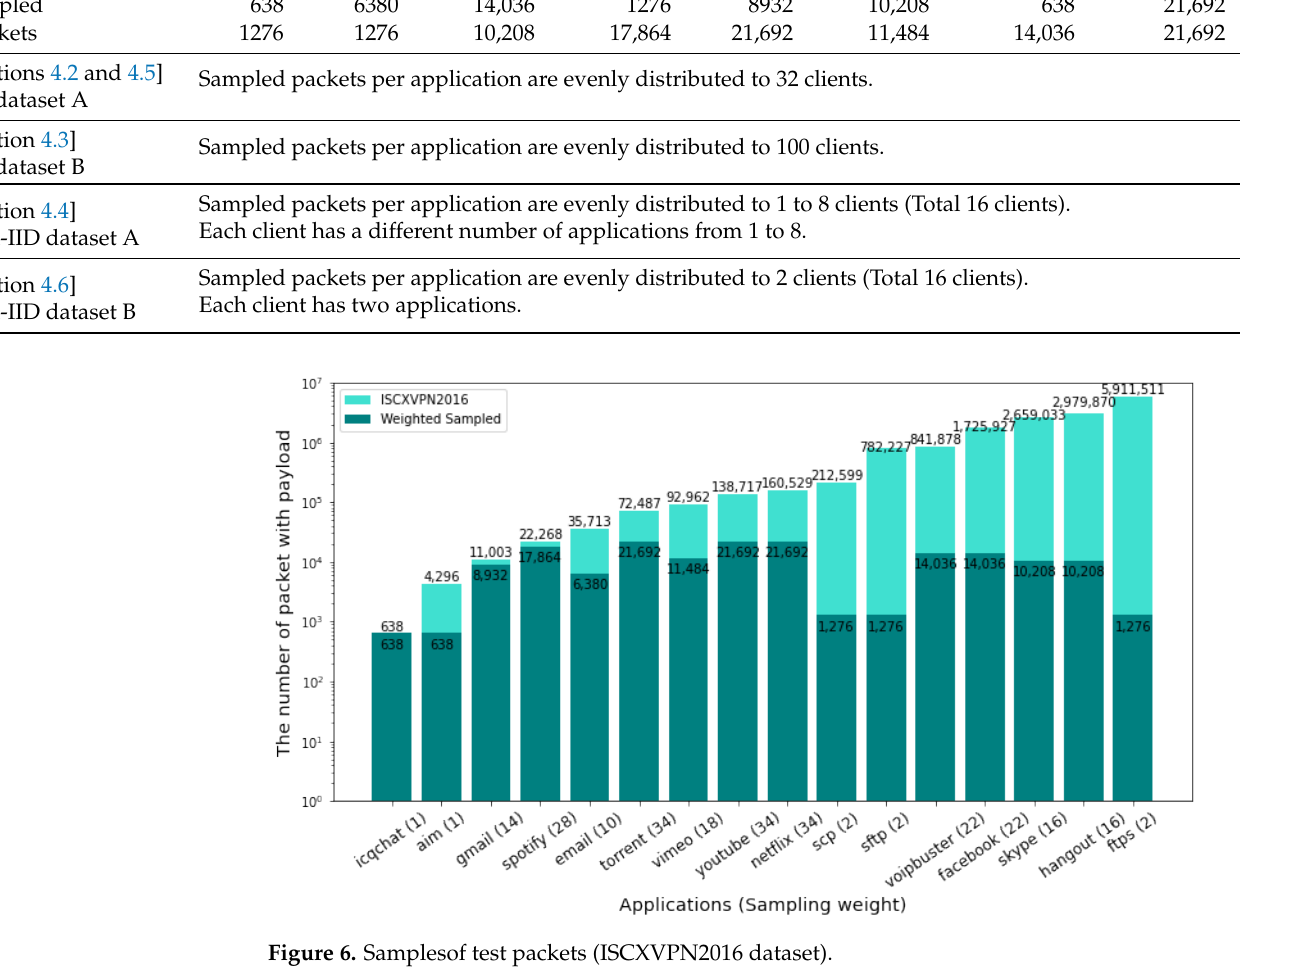
Figure 6. Samplesof test packets (ISCXVPN2016